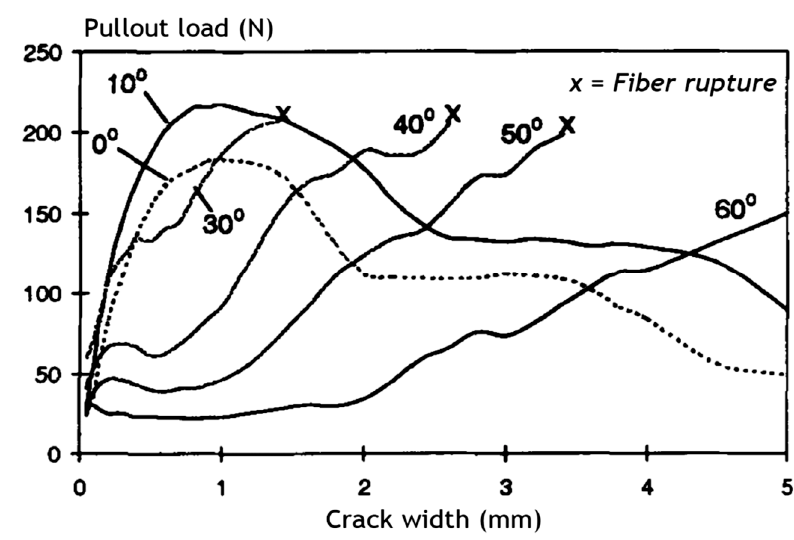
Figure 8. Pull-out behaviour of hooked-end steel fibres at different inclination angles [103].